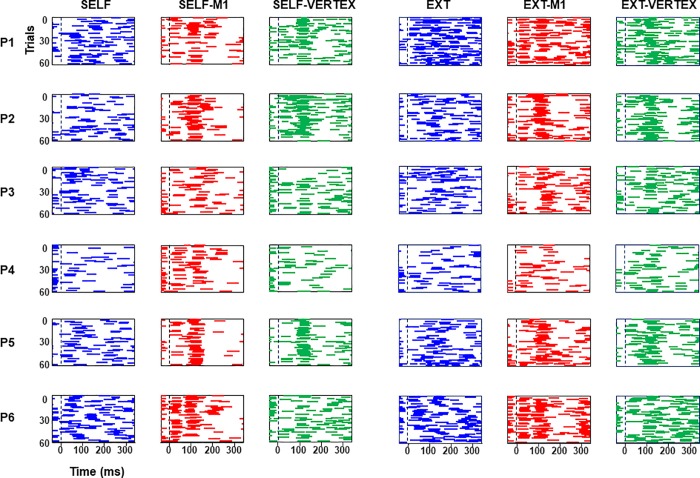
Temporal raster plots of catch-up saccades from all the participants in each experimental condition.Each horizontal segment represents a saccade, and each row represents a trial. All trials are aligned with respect to TMS onset (dotted line), or a comparable moment. Note the drop in saccadic activity followed by a rebound after TMS.